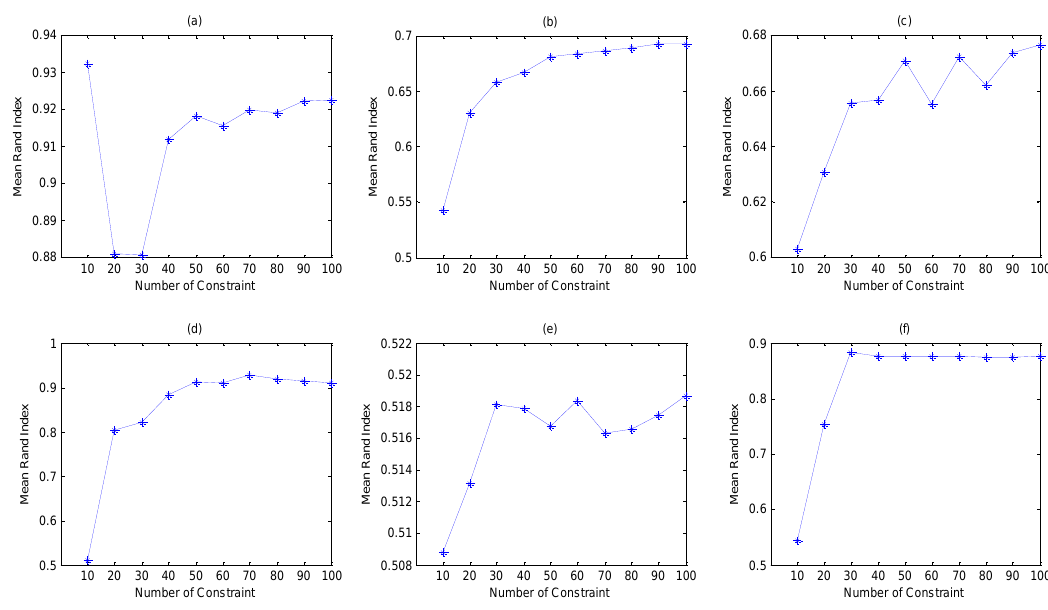
Figure 8. Clustering results of unweighted- SD method versus number of constraints for UCI datasets: (a) Soybean, (b) Heart, (c) Ionosphere, (d) Wine, (e) Sonar, and (f)